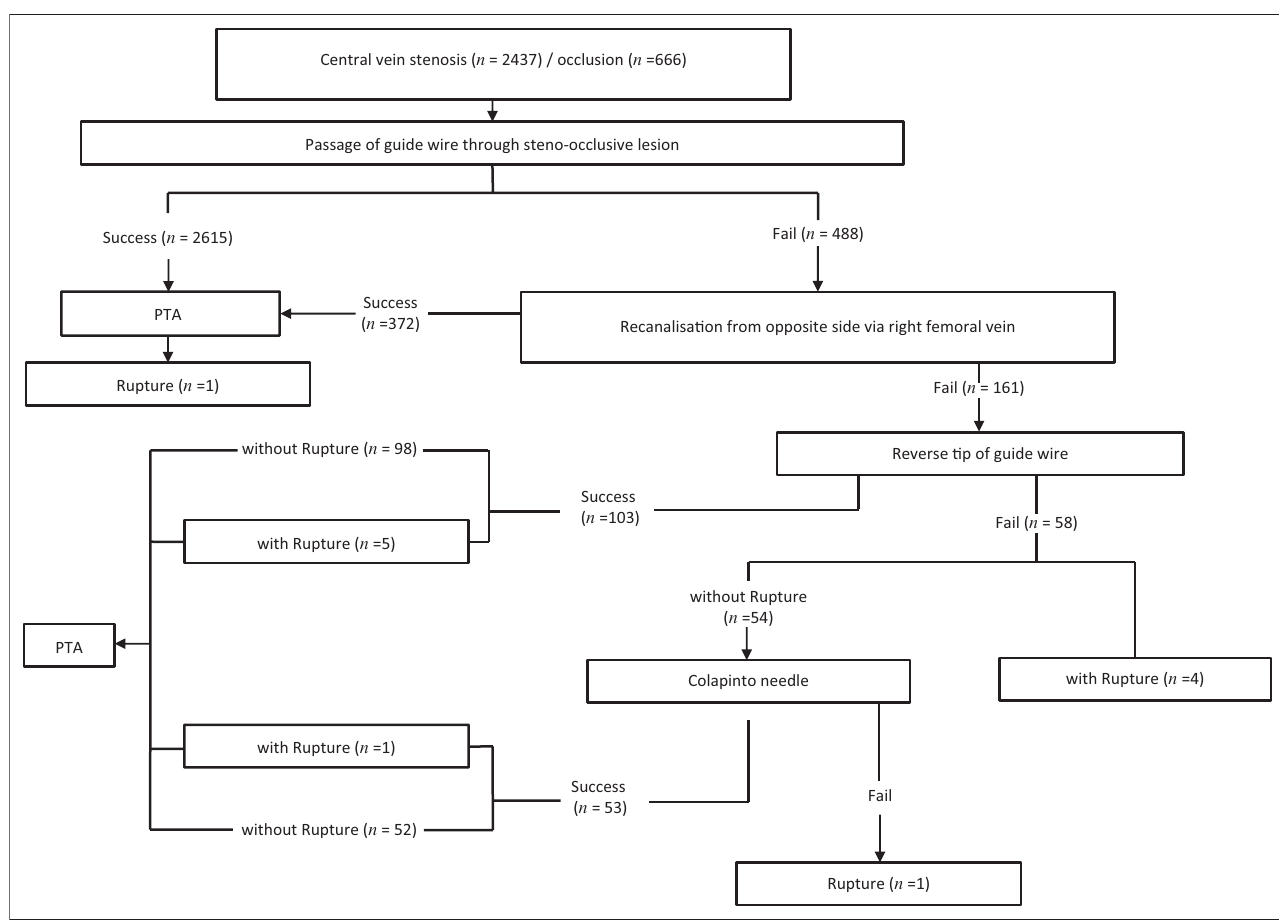
FIGURE 1: Flowchart of the percutaneous transluminal angioplasty for central venous stenosis and occlusion.